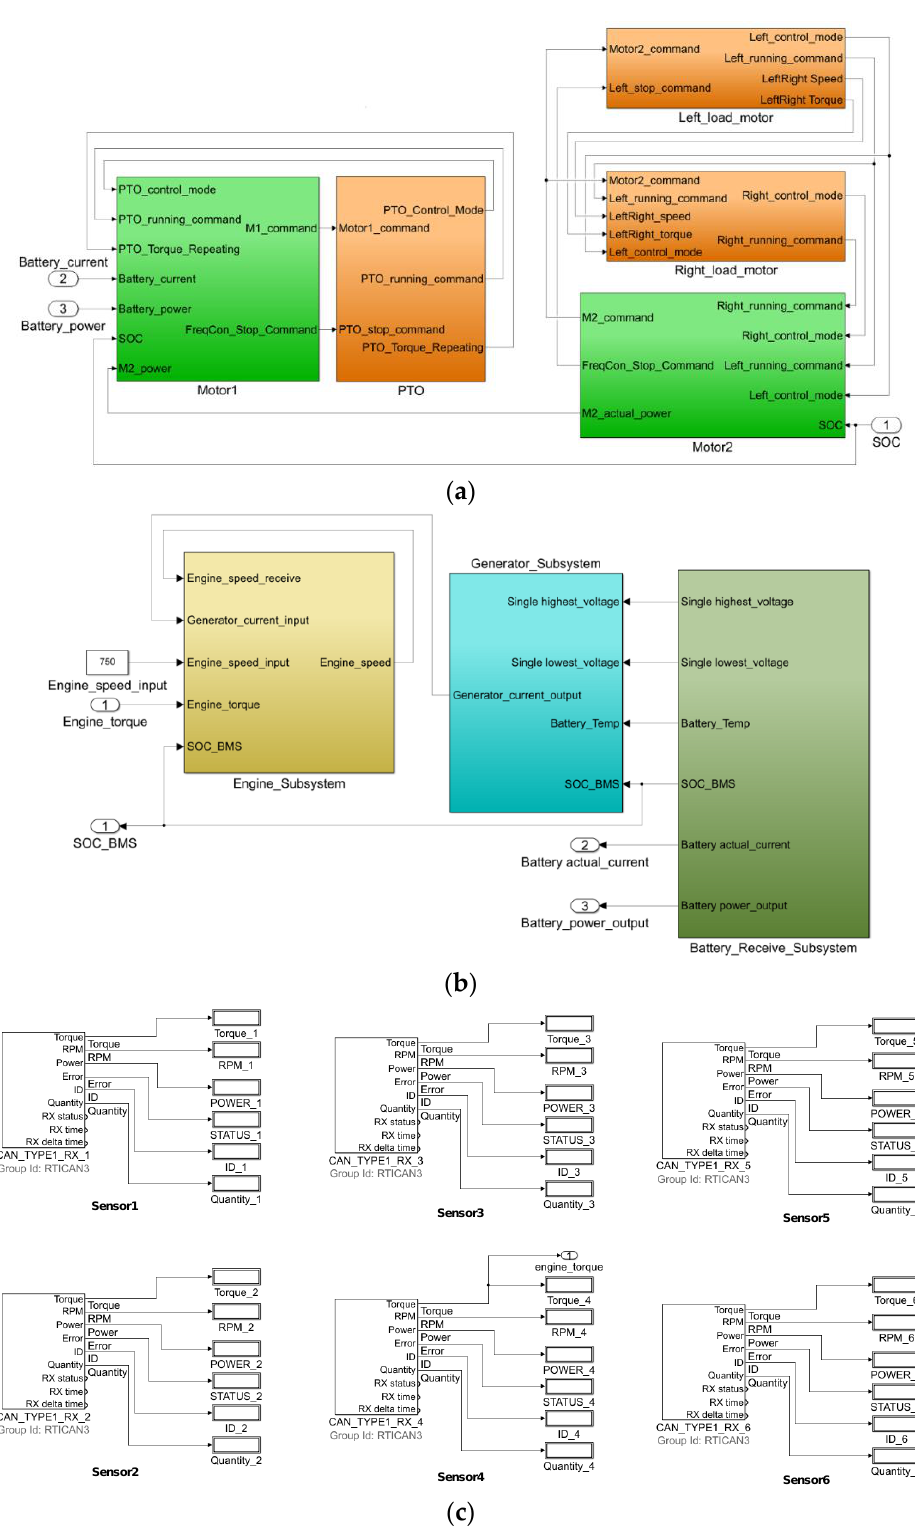
Figure 7. Simulink models of the control and measurement system: ( a ) electric drive model; ( b ) genset and battery model; and ( c ) measurement system model.